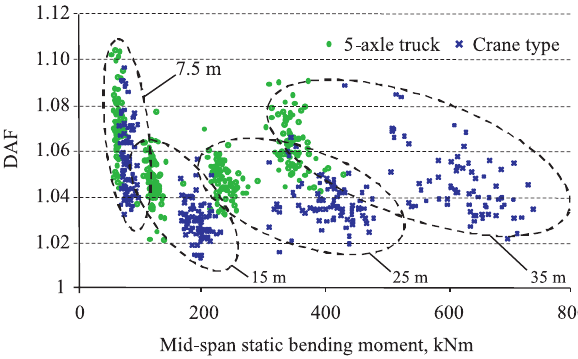
Fig. 6. Mean DAF for vehicles over class B profiles and healthy expansion joint. Results for each span are surrounded within corresponding curve (dashed line)